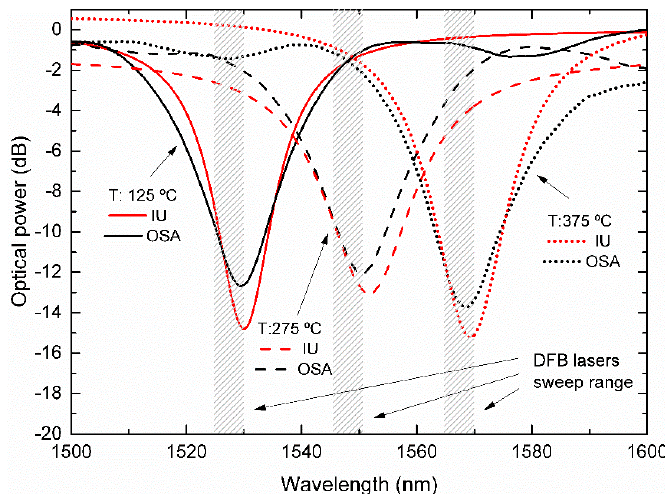
Figure 9. Comparison between the LPFG spectra at three different temperatures as measured by the developed IU curve fittings, with the represented spectral positions of its three DFB lasers, and the real LPFG measured by the conventional BBLS/OSA scheme.